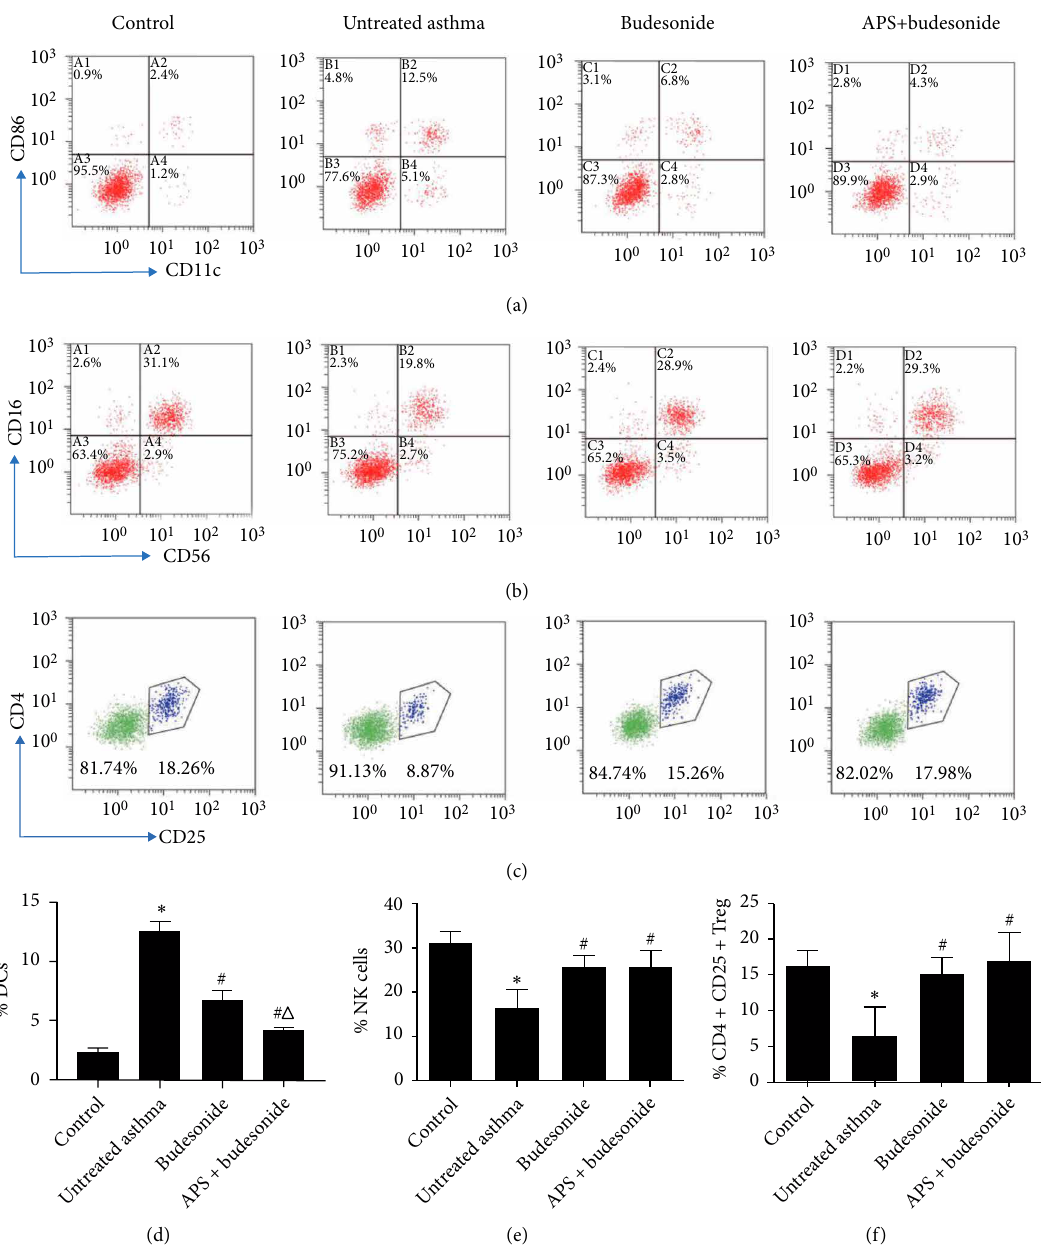
Figure 2: Flow cytometric analysis of DCs, NK cells, and Treg cells. (a–c) The percentage of DCs, NK cells, and Treg cells. (d–f) Results from gated cells were visualized by bar charts as percentages of DCs, NK cells, and Treg cells. Mean ± SD is presented for each group. compared with control group; # 𝑃 < 0.05 , compared with untreated asthma group;